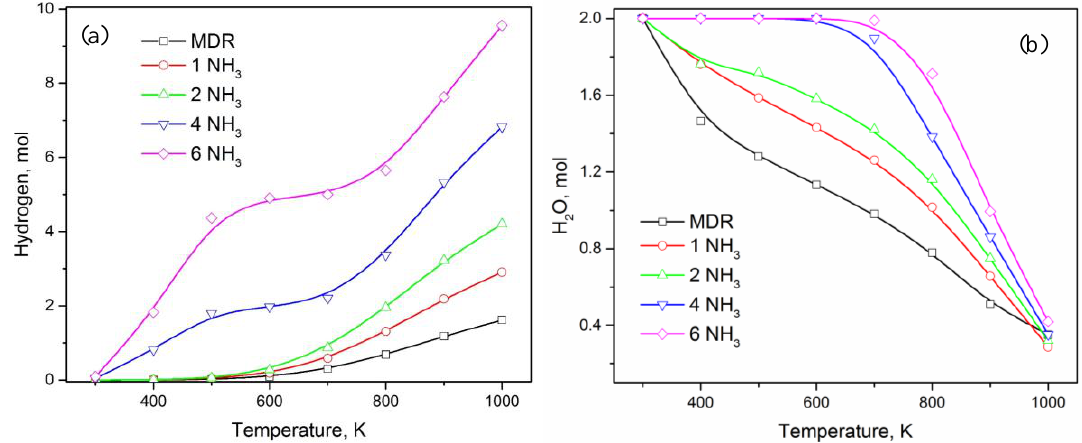
Figure 7. ( a ) Effect of ammonia content in DMR on H 2 in product, and ( b ) H 2 O in product.